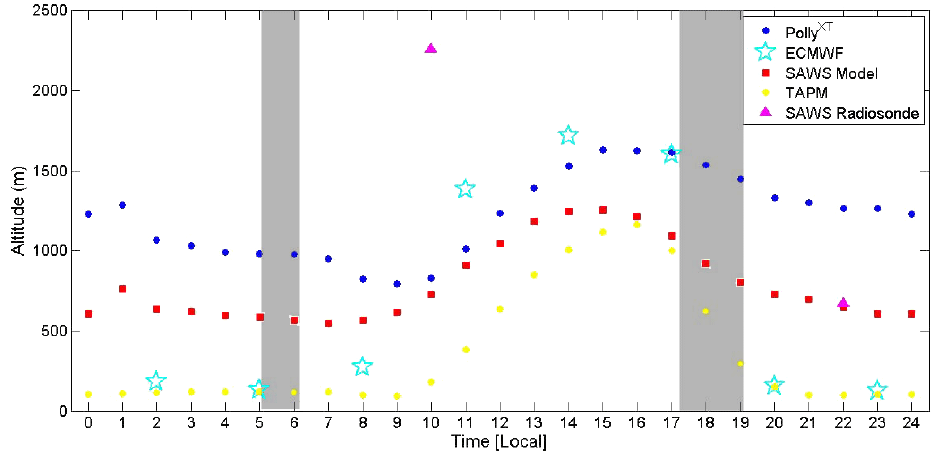
Fig. 10. PBL diurnal cycle observed in Elandsfontein during 2010. The grey shading indicates the times of sunrise and